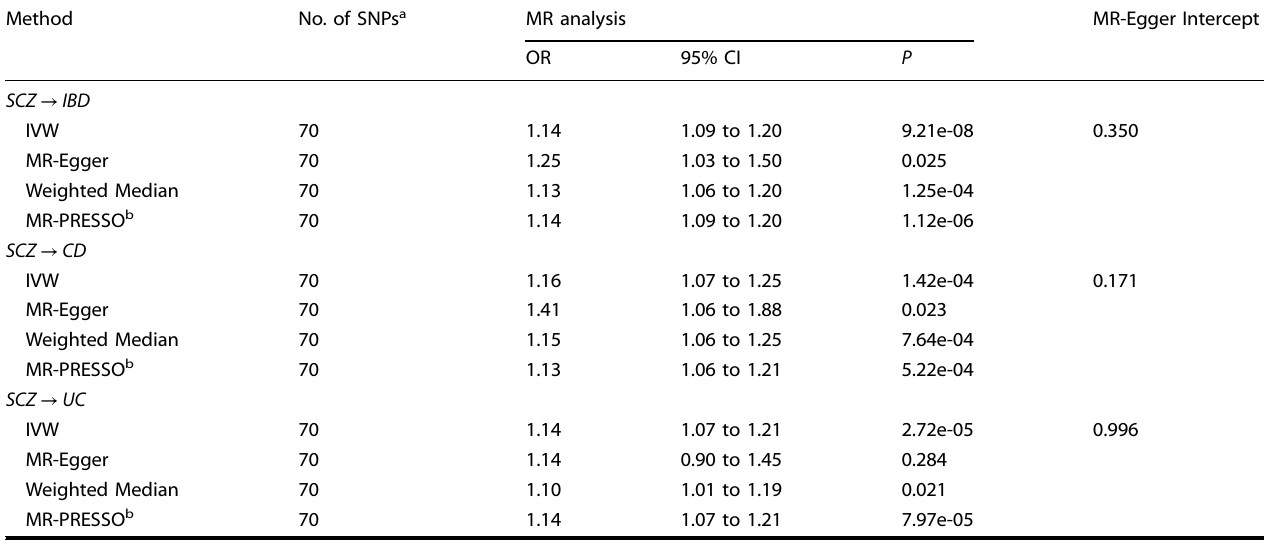
Table 1. Mendelian randomization estimates for causal effects of genetically predicted SCZ on IBD and its subtypes.